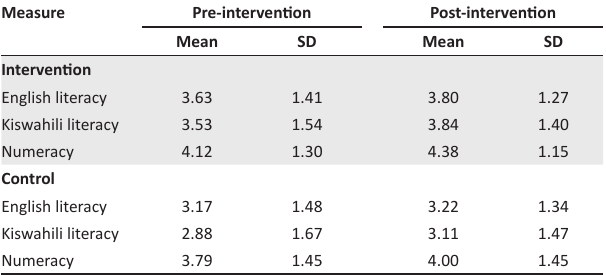
group, the intervention group experienced a greater increase TABLE 1: Mean values and standard deviations of Uwezo test scores.